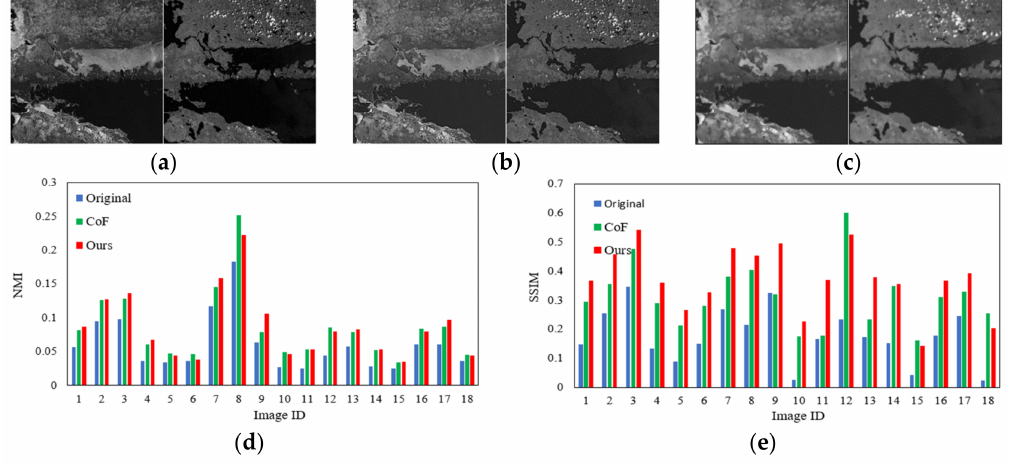
− CoF filtering, and the comparison results of G θ − CoF filtering 2, σ 2, σ − CoF filtering; ( c ) Image after 2, σ − CoF filtering and CoF filtering; ( e ) SSIM scores 2, σ